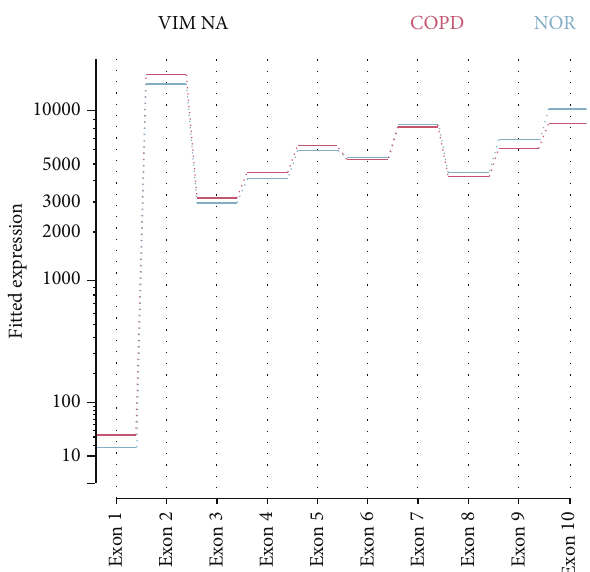
Figure 7: Exon usage of vimentin according to COPD status. COPD subjects showed more exon usage of exon 1 to exon